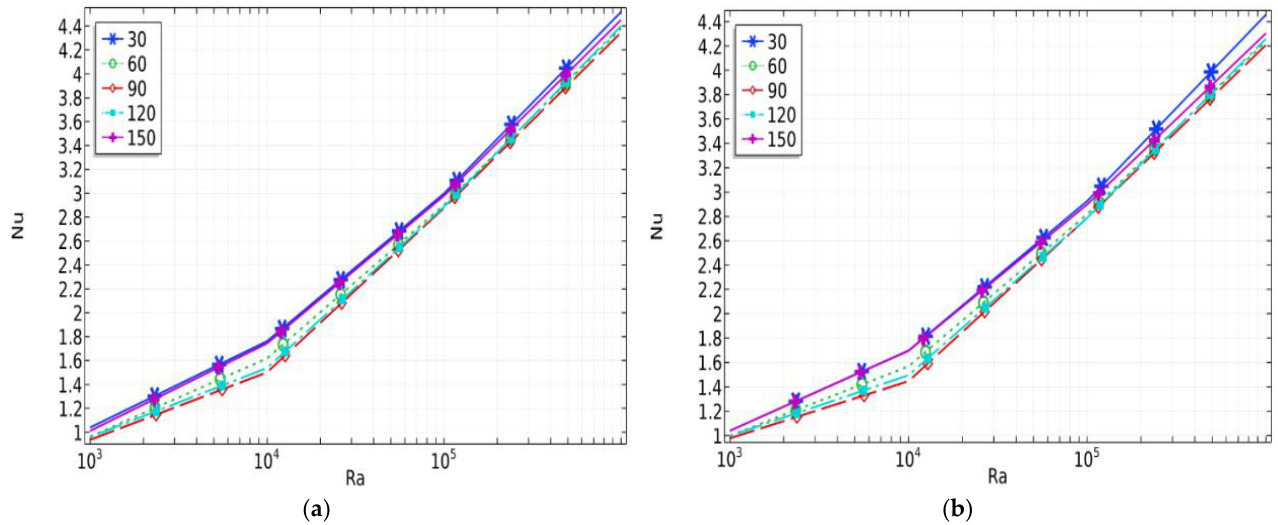
Figure 8. Average Nusselt number graph for various baffle inclination angle with 𝑅𝑎 and  at 𝐾𝑟 = 1, at ( a ) 𝜙 = 0, and ( b ) 𝜙 = 0.06. Kr = 1, at ( a ) φ = 0, and ( b ) φ =